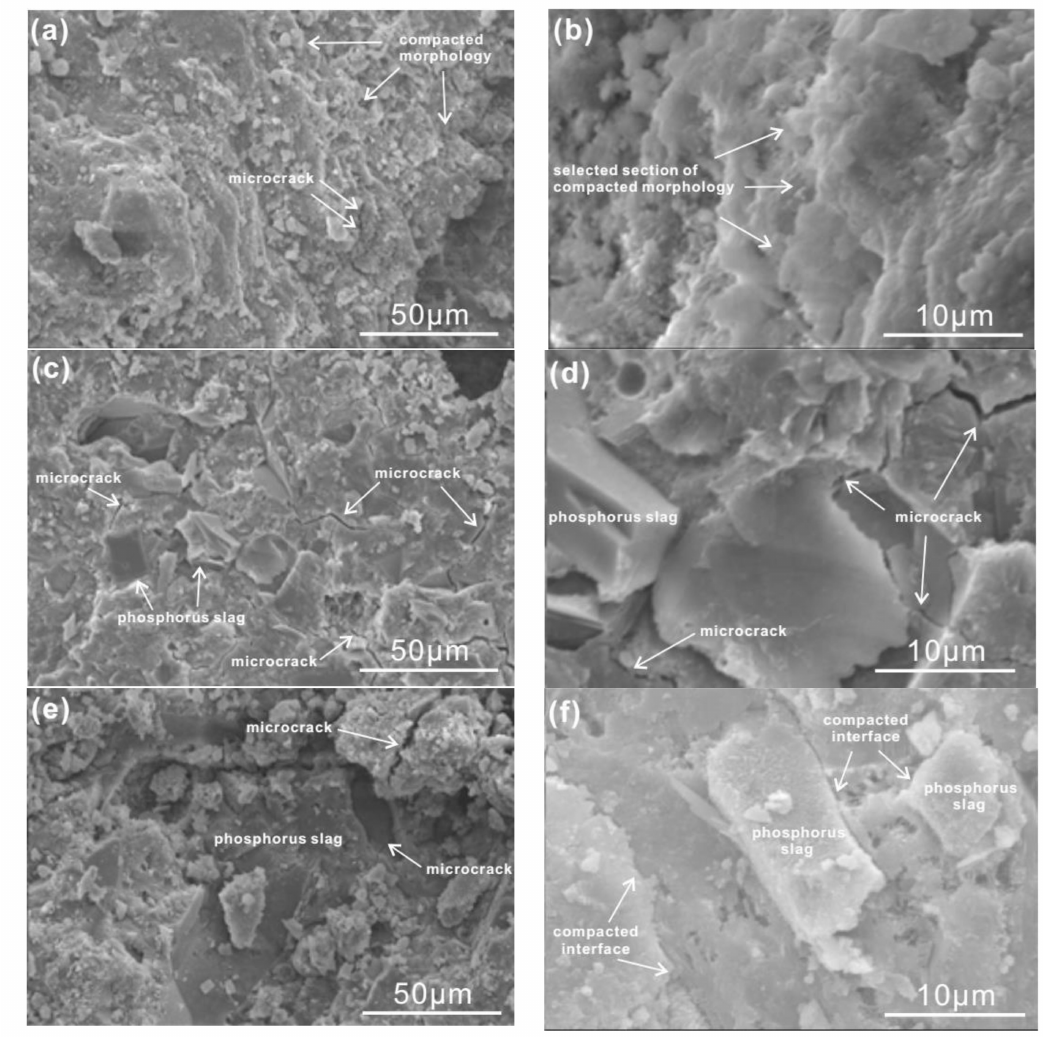
Figure 11. SEM images of cement pastes at di ff erent ages. ( a , b ) Plain pastes at 3 days and 28 days; ( c , d ) cement pastes with 30% by mass of phosphorus slag at 3 days and 28 days; ( e , f ) cement pastes with 30% by mass of phosphorus slag and the chemical activator at 3 days and 28 days.